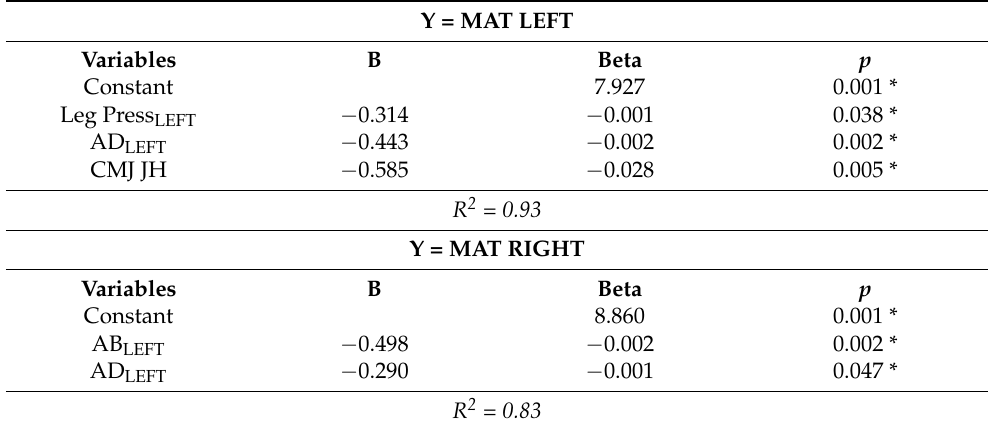
Table 3. Stepwise regression analyses relating left and right MAT with hip maximum isometric strength, Keiser leg press peak power, vertical jumping, and sprint performance